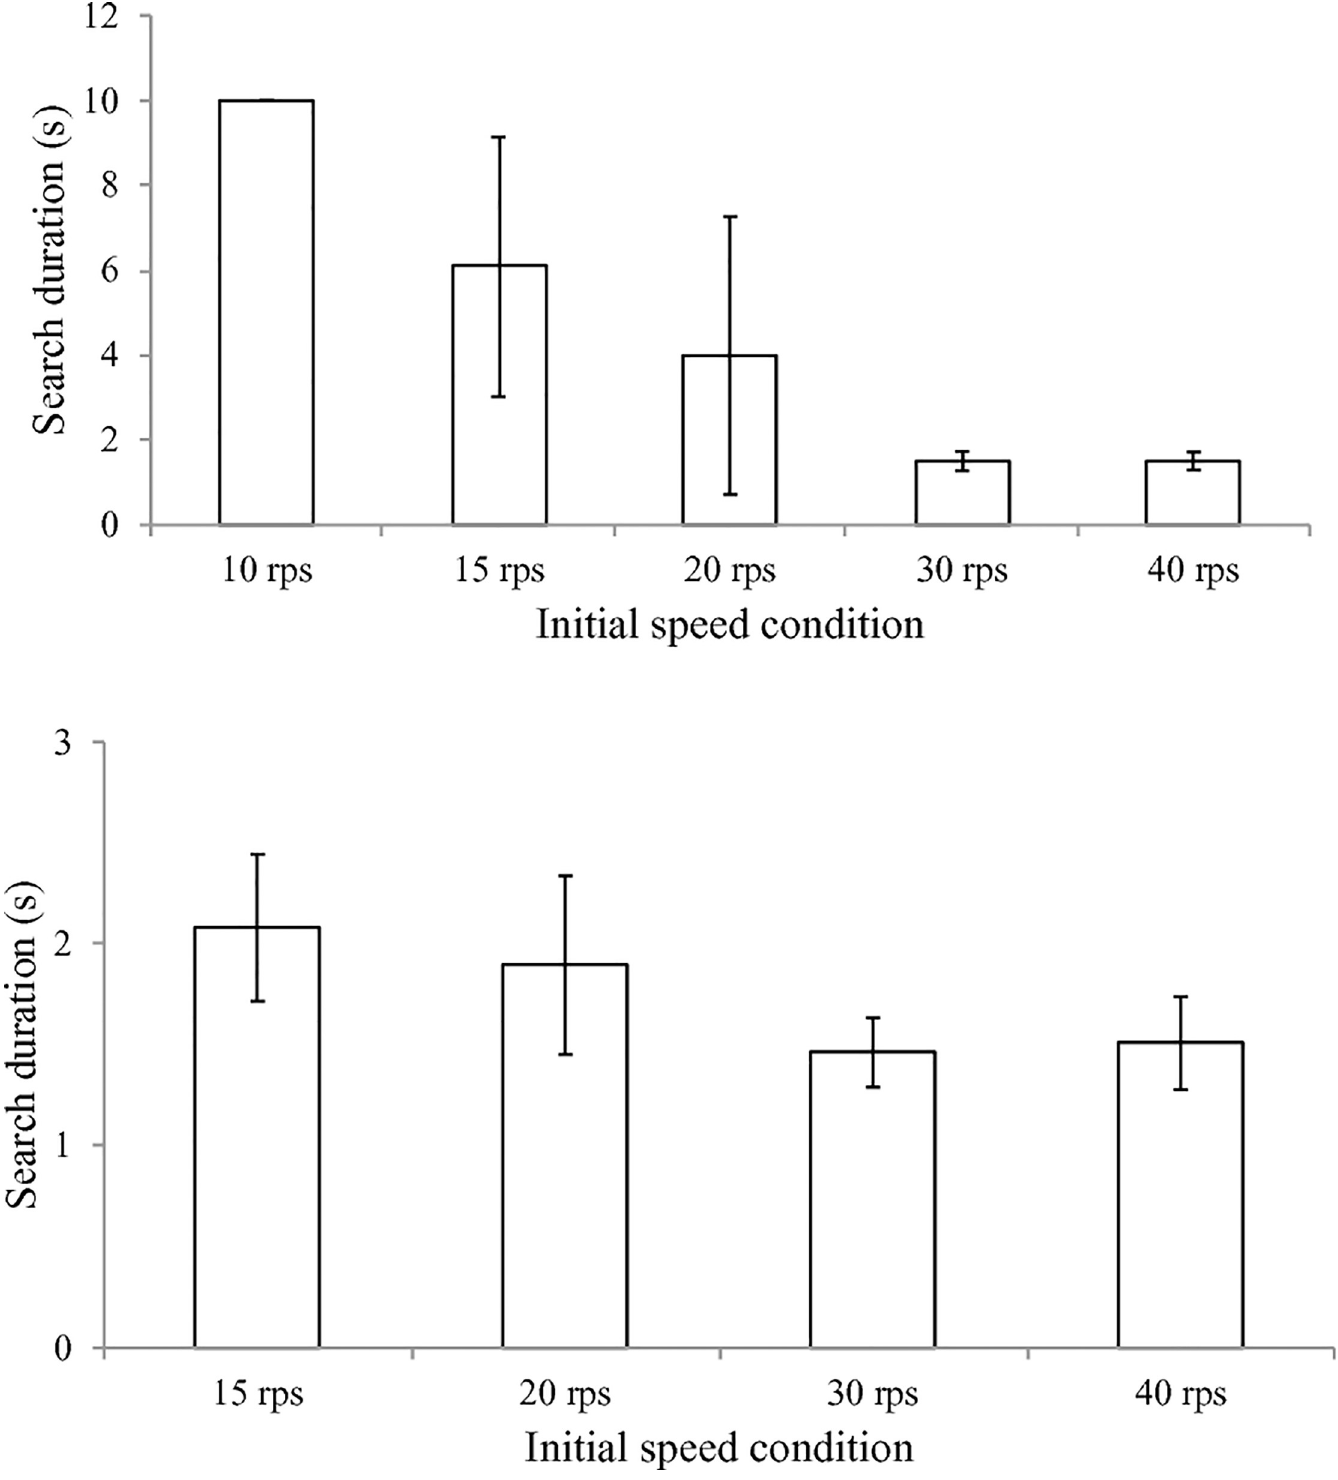
Fig 3. Average search duration for the initial speed condition over 16 participants (top panel) and average search duration of the success trials for the initial speed condition (bottom panel).